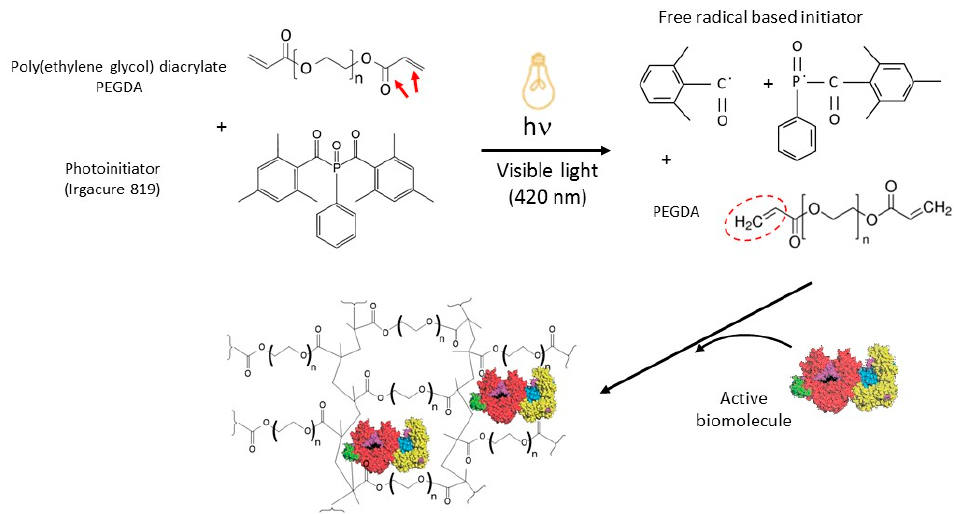
Figure 2. Hydrogel 3D printing process. Poly(ethylene glycol) diacrylate photopolymerization reaction and inclusion of biomolecules.